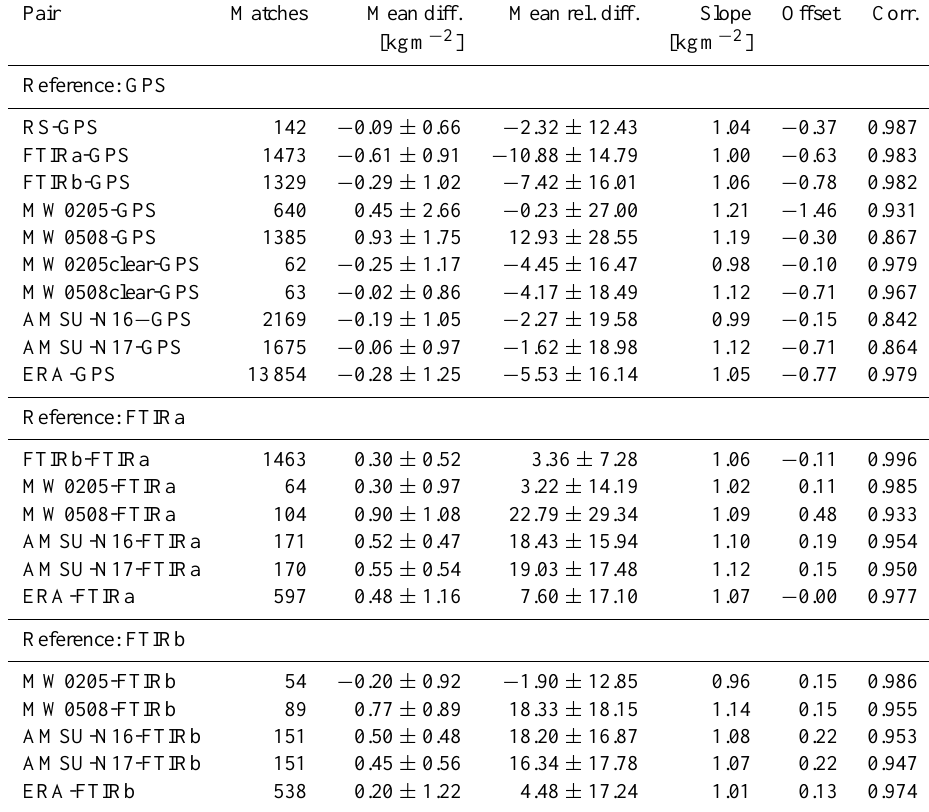
Table 4. Statistics of all comparisons. Matches is the number of matches between the two datasets. Mean diff. is the mean value of the differences plus/minus its standard deviation. Mean rel. diff. is the same for the relative difference. Slope and Offset are the slope and offset of the linear regression line, and Corr. is the linear (Pearson) correlation